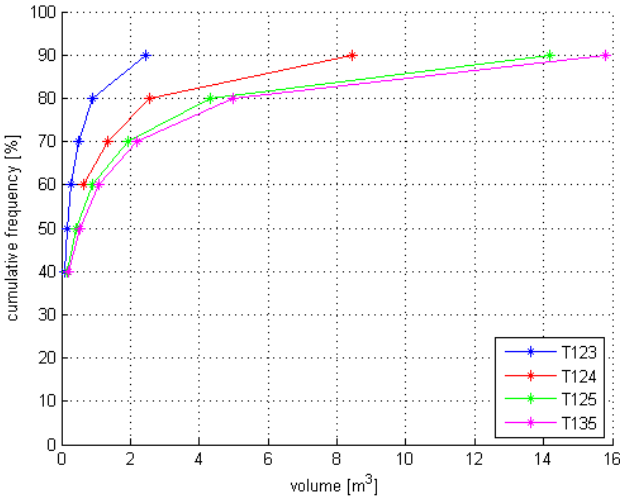
Figure 8. In situ block size distribution (IBSD) calculated according to Equation (2).